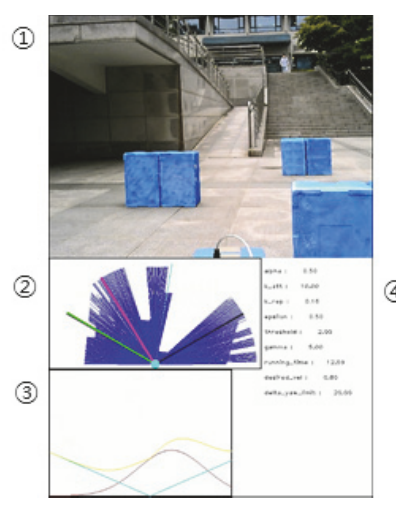
Figure 15: Program screen recorded by the PC on the robot.